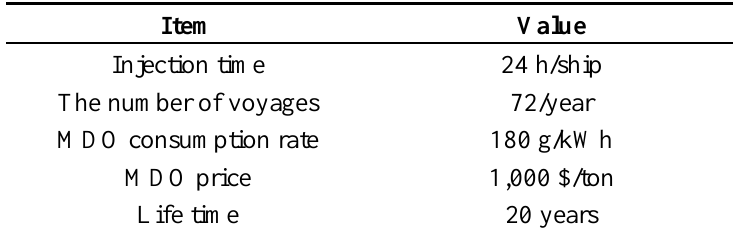
Table 3. Assumptions for estimating the OPEX.